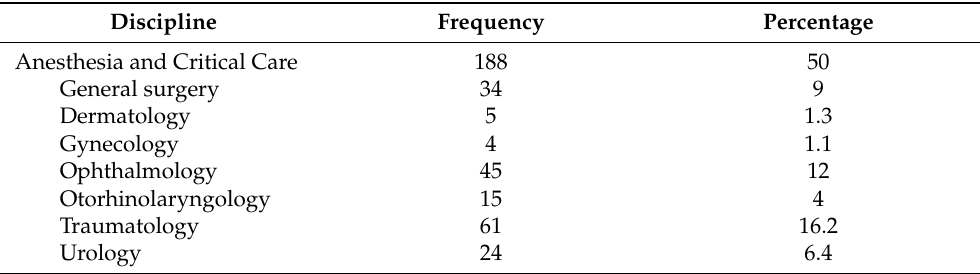
Table 4. Surgical consent forms of the intervened patients.